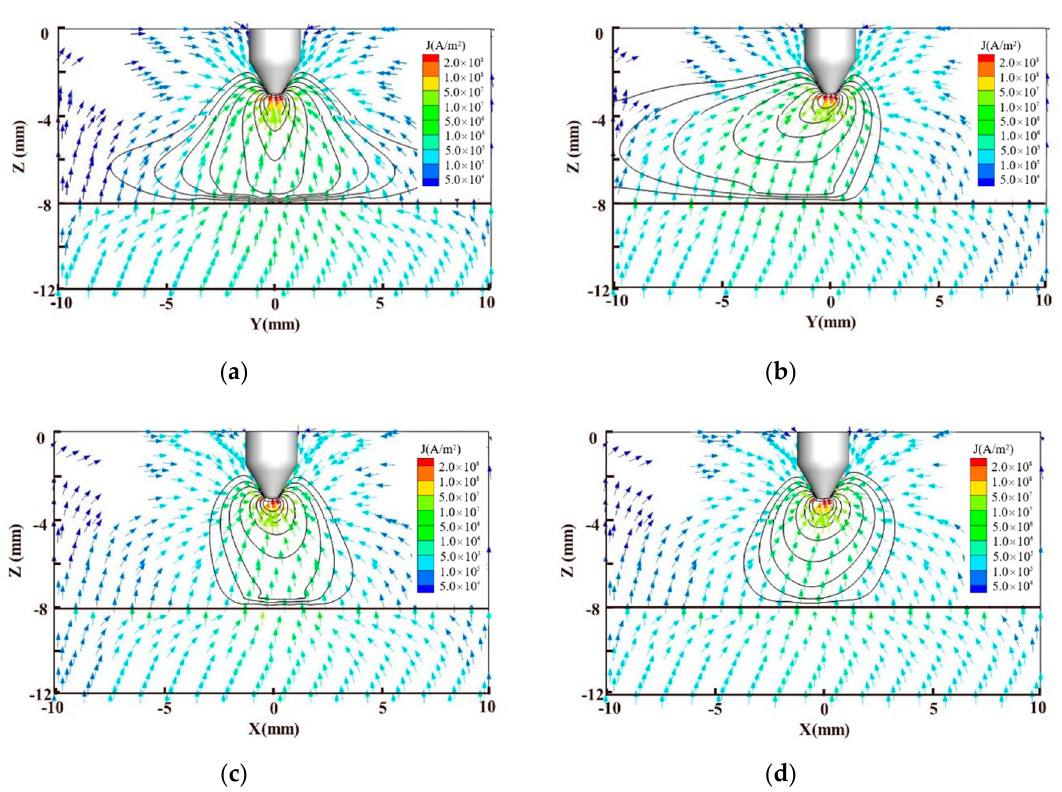
Figure 12. Current density distributions: ( a ) I e = 0 ( yoz plane), ( b ) I e = 3 A, t = t 1 ( yoz plane), ( c ) I e = 3 A, t = t 1 ( xoz plane), and ( d ) I e = 3 A, t = t 2 ( xoz plane).